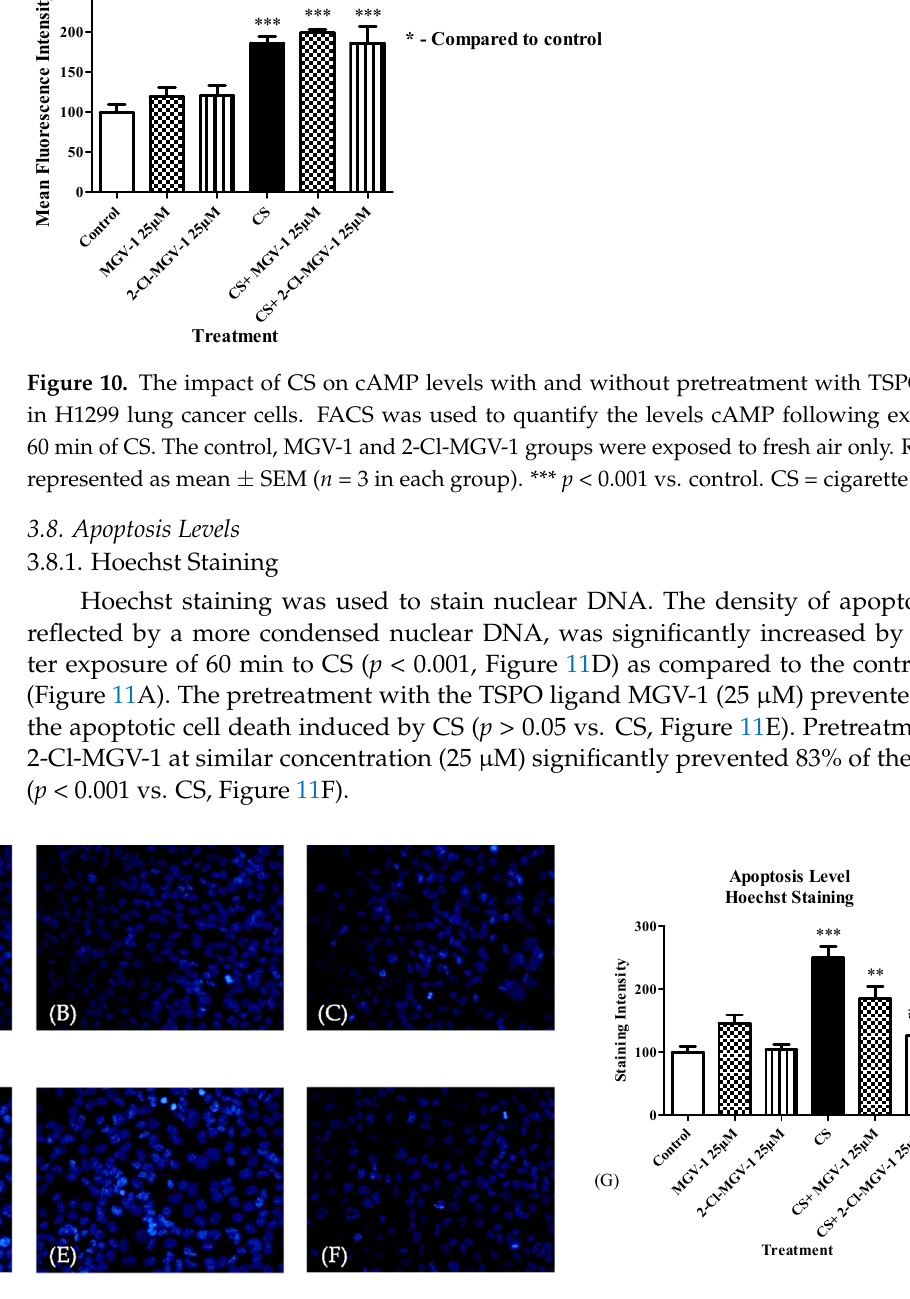
Figure 11. Apoptosis levels in H1299 lung cancer cells as measured by Hoechst staining. The fluorescence intensity of Hoechst staining was determined using microscopic imaging for: ( A ) the control group; ( B ) group of cells pretreated with MGV-1 and exposed to fresh air; ( C ) group of cells pretreated with 2-Cl-MGV-1 and exposed to fresh air; ( D ) group of cells exposed to CS without pretreatment; ( E ) group of cells pretreated with MGV-1 and exposed to CS; ( F ) group of cells pretreated with 2-Cl-MGV-1 and exposed to CS. ( G ) Representative bar graph. Results are expressed as mean ± SEM ( n = 4 in each group). ** p < 0.01 and *** p < 0.001 vs. control, ### p < 0.001 vs. CS. CS = cigarette smoke.